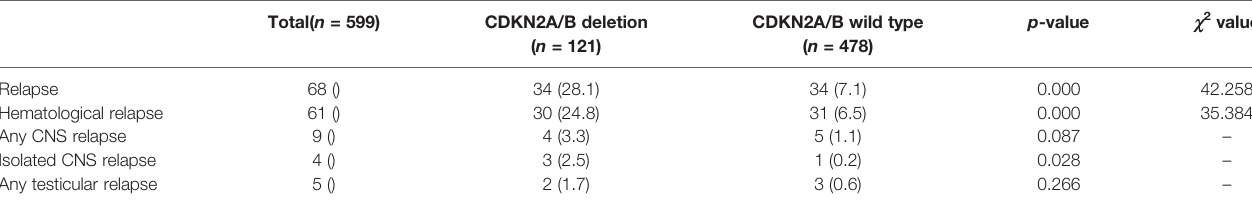
Total( n = 599) CDKN2A/B deletion